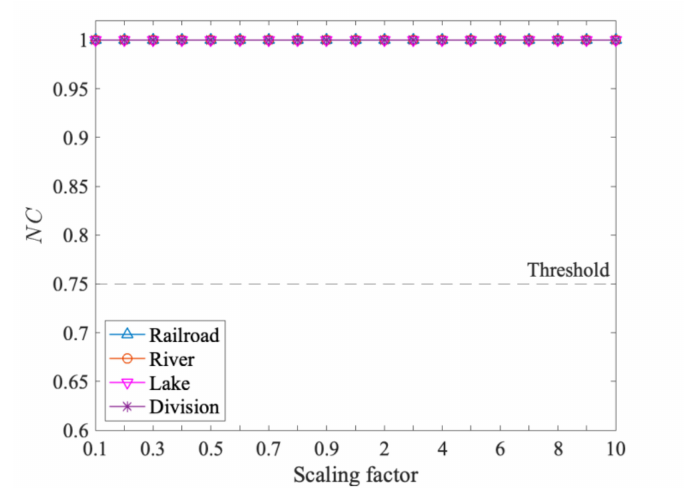
Figure 12. The results of scaling attack.